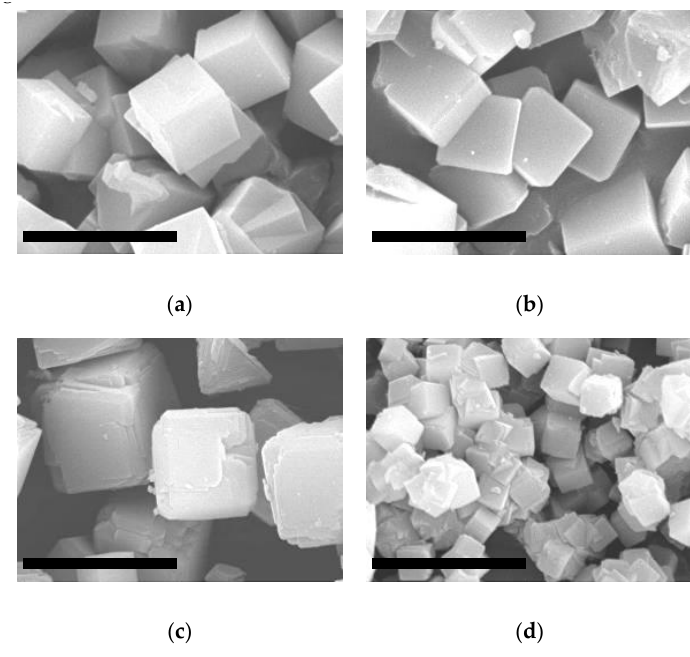
Figure 3. SEM images of ITQ-29 samples synthesized in different conditions: ( a ) static, 4.5 days; ( b ) static, 3.5 days; ( c ) dynamic, 4.5 days; ( d ) dynamic, 3.5 days. Scale bars correspond to 6 µm.